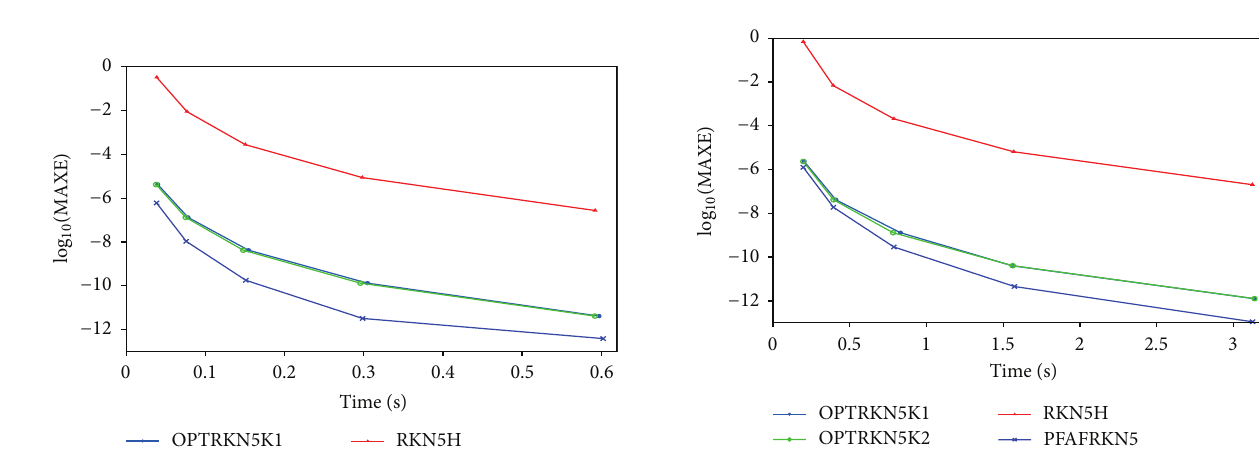
Figure15:EfficiencycurvesforallmethodsoforderfiveforProblem 4 with ℎ = 1/2 𝑖 , 𝑖 = 1,...,5 .